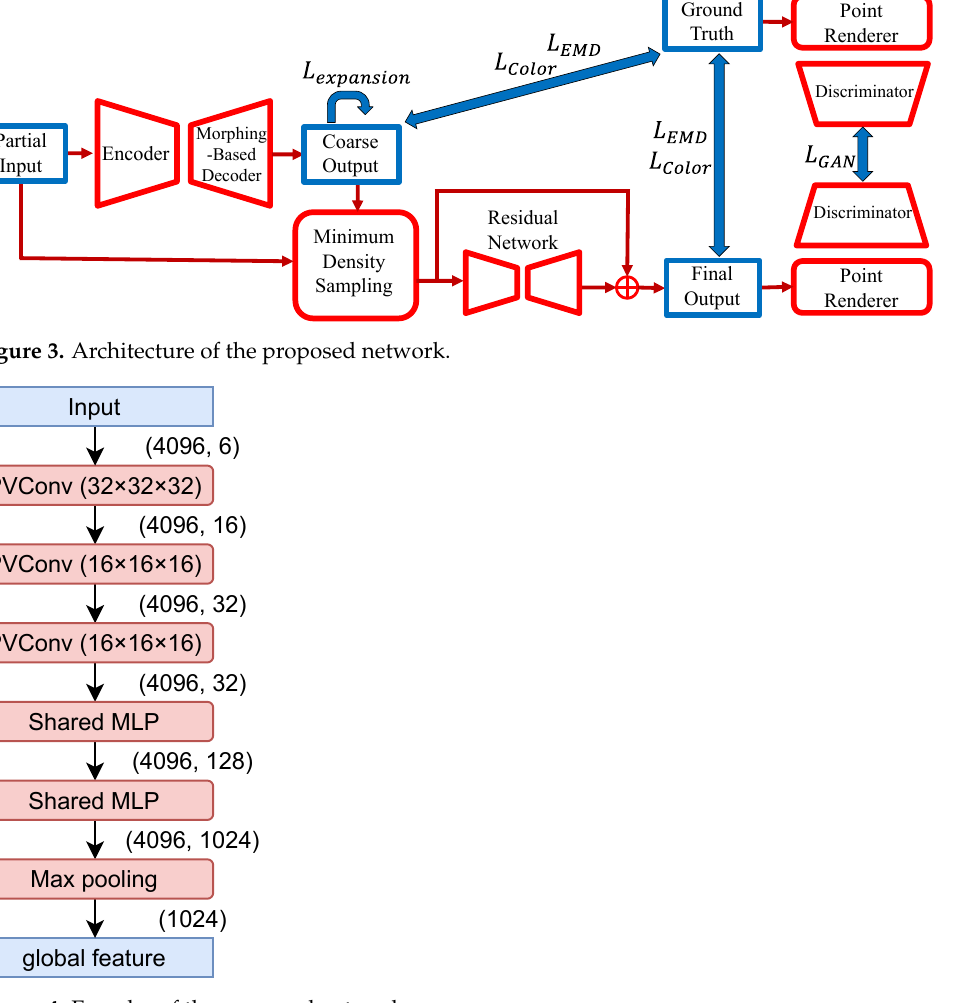
Figure 4. Encoder of the proposed